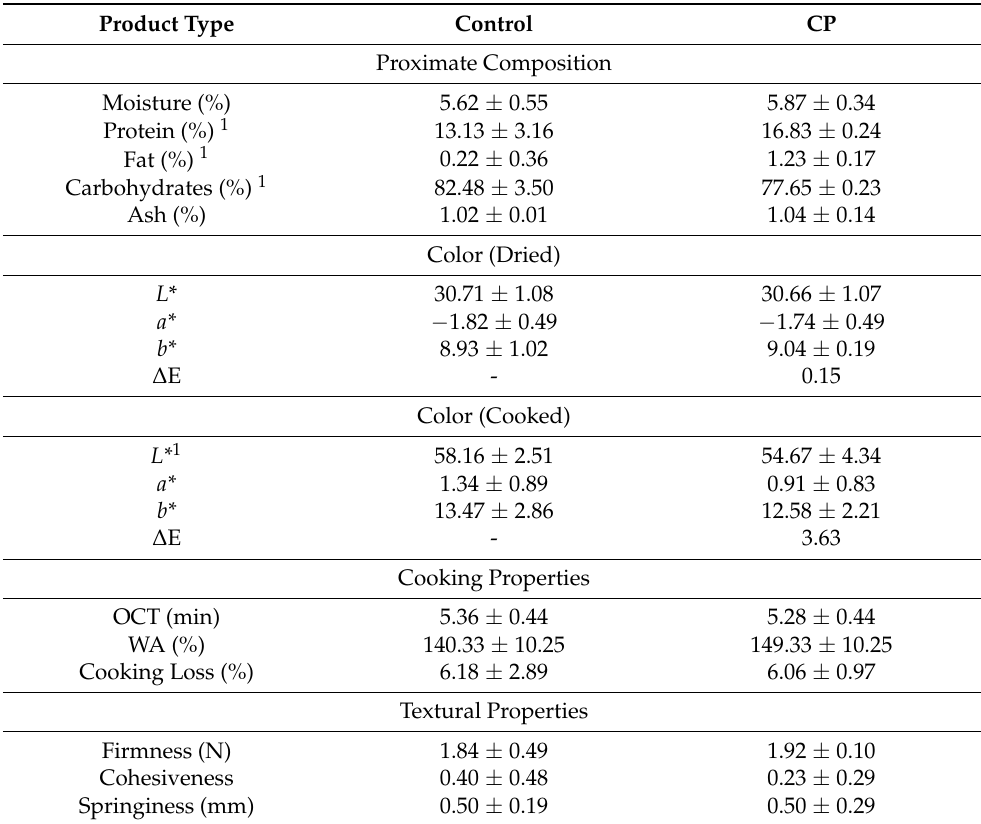
Table 5. Proximate composition of the dried pasta (on a dry basis), color, cooking properties, and textural properties of both dried pastas developed. The means with 95% confidence intervals are shown. All percentages were rounded to the nearest hundredth place. Parameters that were denoted were found to be significantly different ( p <